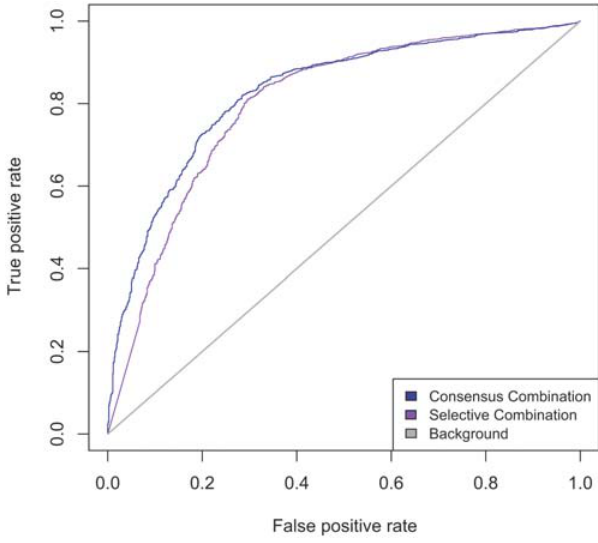
Figure 7. Evaluation According to PHUNCTIONER Protocol. Following the protocol described for evaluation of the PHUNCTIONER method in [17], the ROC curve considers only the highest scoring predicted level three GO term for each query protein. A diagonal line in the ROC plot indicates random predictor performance. Optimal performance is demonstrated by a curve passing through the upper left corner.